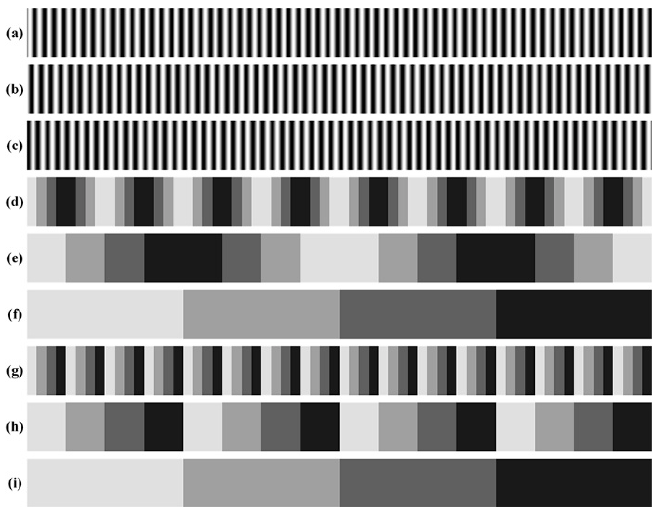
Figure 8. Projected patterns. ( a – c ) phase-shift patterns, ( d – f ) n GC patterns, ( g – i ) n GL patterns.